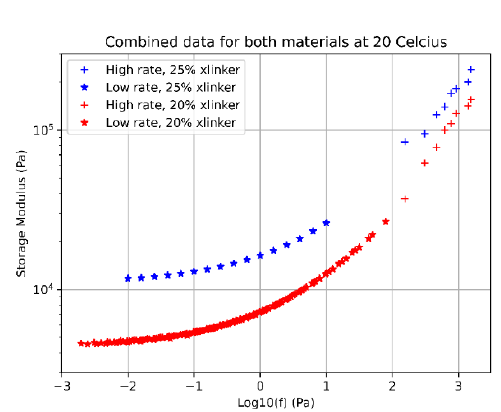
Fig. 5. Combined low and high rate data for both materials at 20 o